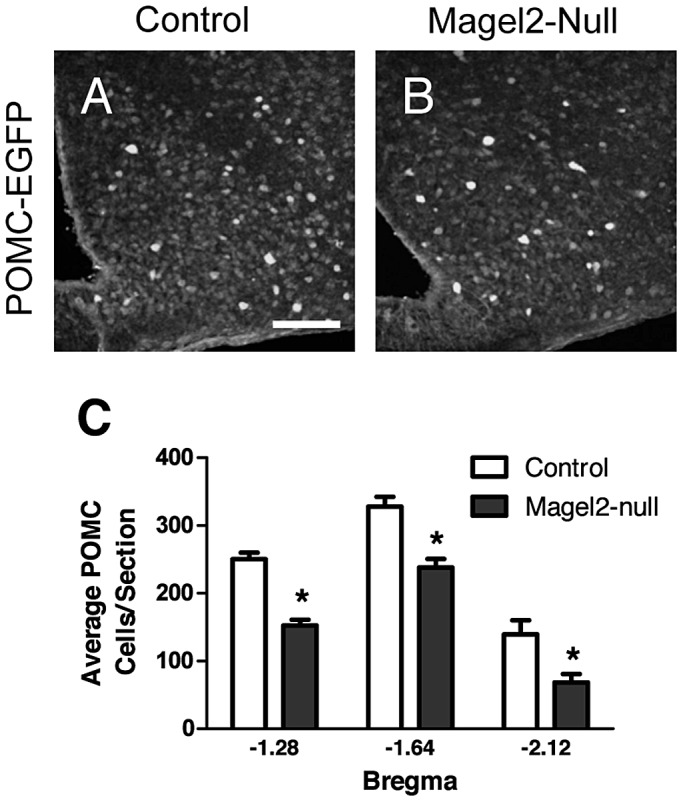

Magel2-null mice have fewer ARC POMC neurons.A–B) Representative images of GFP (POMC) IHC in A) control and B) Magel2×POMCEGFP mice. Scale bar 100 µm. C) Magel2×POMCEGFP mice have fewer GFP expressing (POMC) cells at all levels of the ARC (Bregma −1.28, 39% reduction, *P<10−8; Bregma −1.64, 27% reduction, *P<10−5; Bregma −2.12, 52% reduction, *P<0.01), compared between genotypes by Student's t-test. Values are means ± SEM.